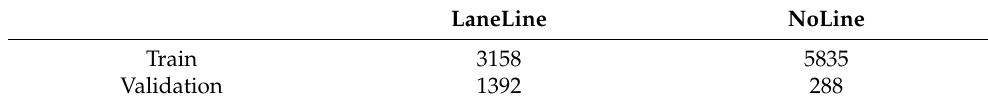
Table 1. The number of data for training and validation.